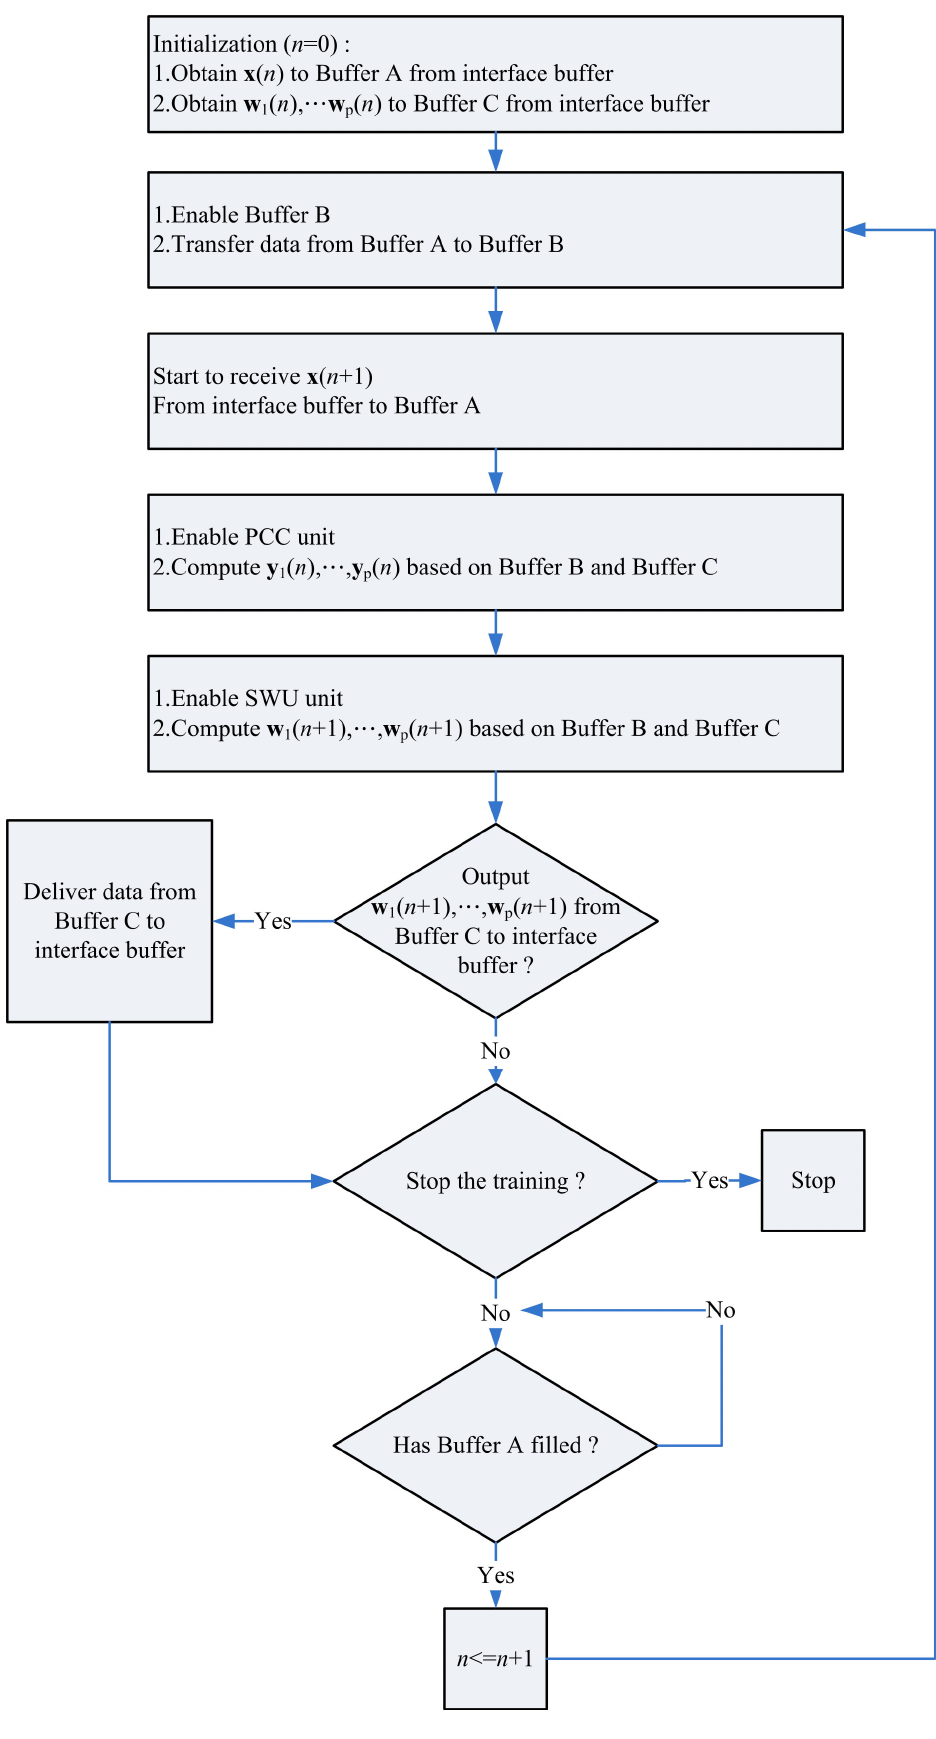
Figure 17. The operation of the controller of the proposed